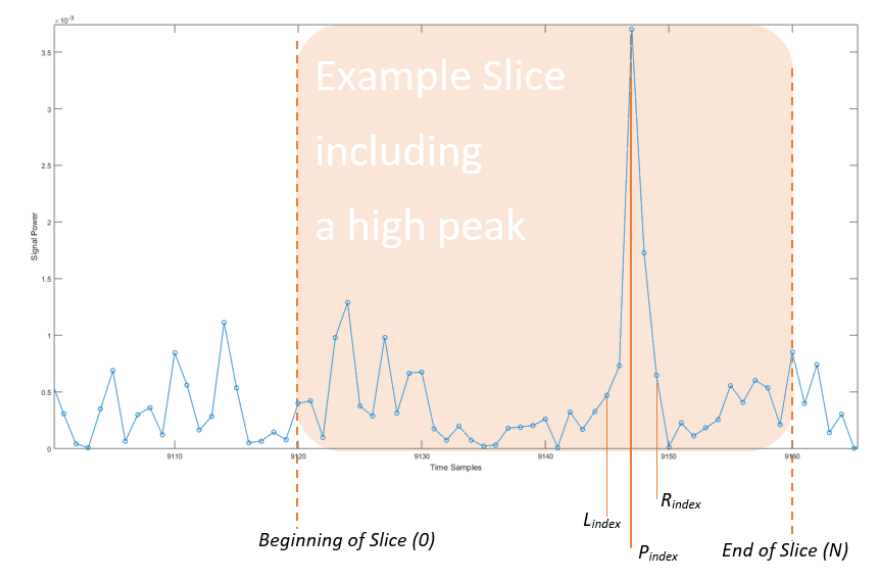
Figure 6. An example of a slice including a high